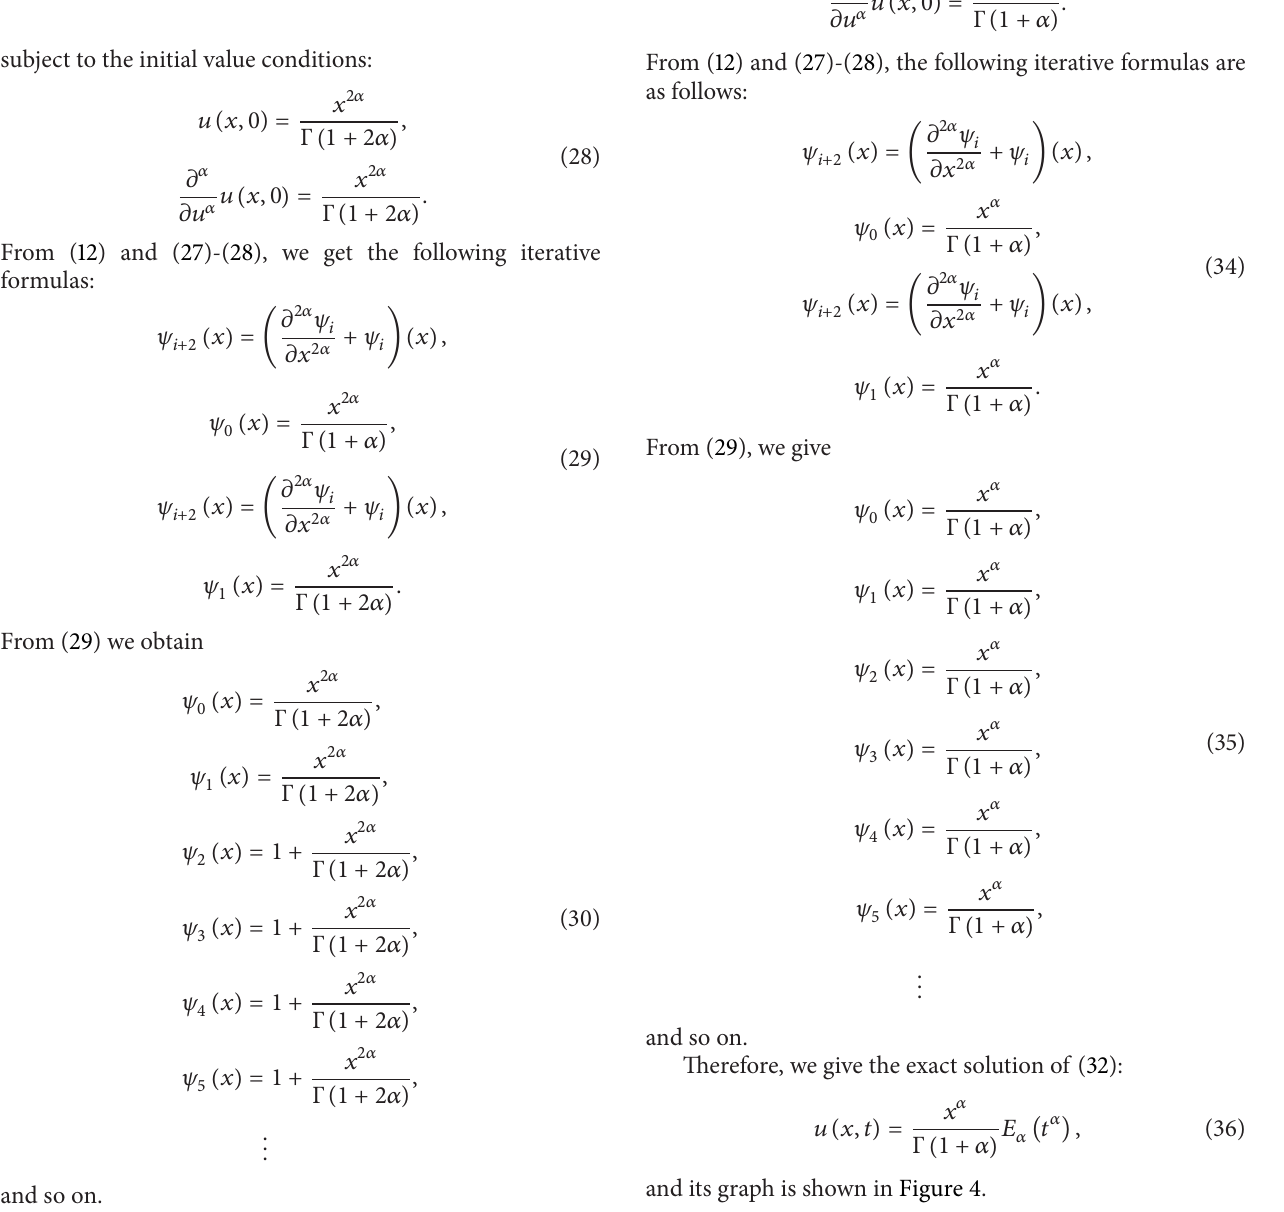
Figure 2: The plot of 𝑢(𝑥,𝑡) for the parameter 𝛼 = ln 2/ ln 3 .